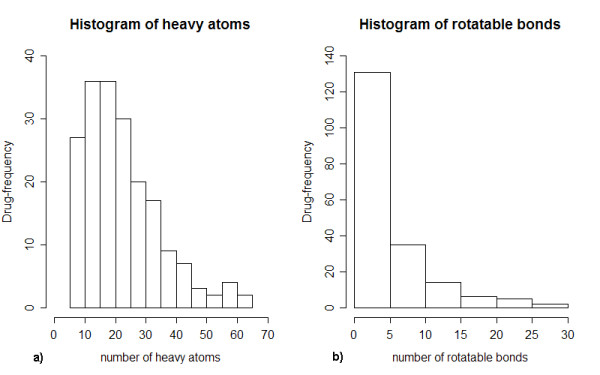
Drug distribution per heavy atoms. a) Histogram of 193 analysed drugs ordered by number of heavy atoms. b) Histogram of 193 analysed drugs ordered by number of rotatable bonds.